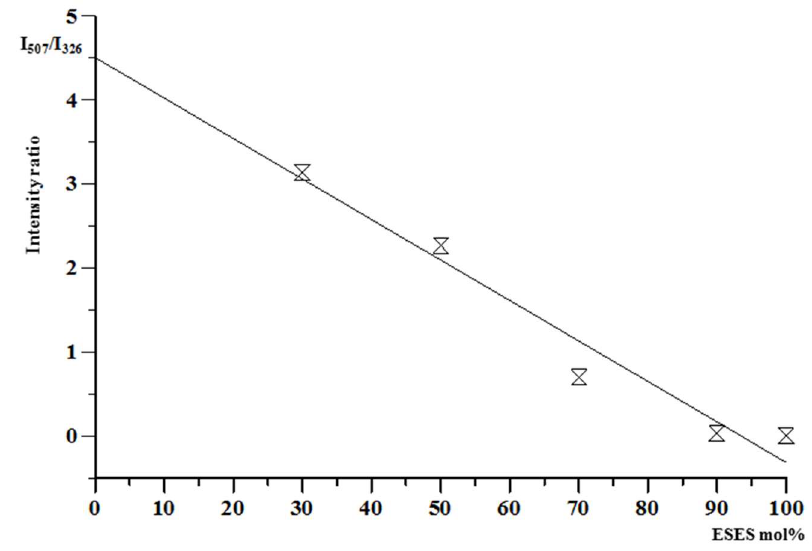
Figure 9. Evolution of the relative intensity of peak ions at m / z 507 and 326 as a function of the ES–ES mol% in the copolymers.